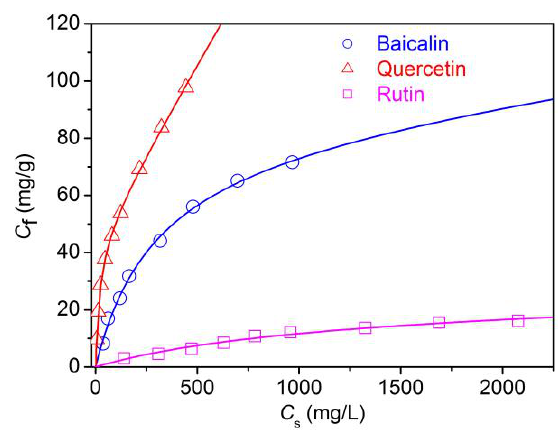
Figure 4. Adsorption isotherms of flavonoids for polyamide fiber and Langmuir – Nernst plots.